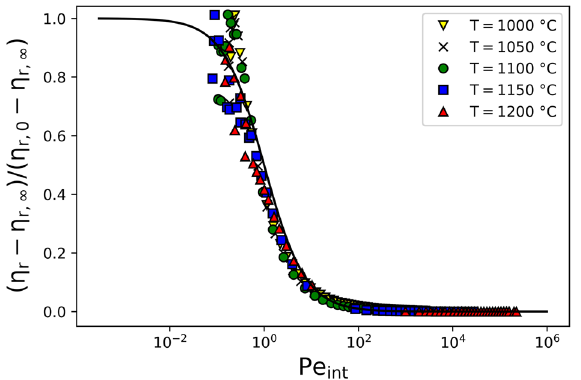
Figure 6. Normalised relative viscosity from Hanotin et al. 17 against Pe number for interactive